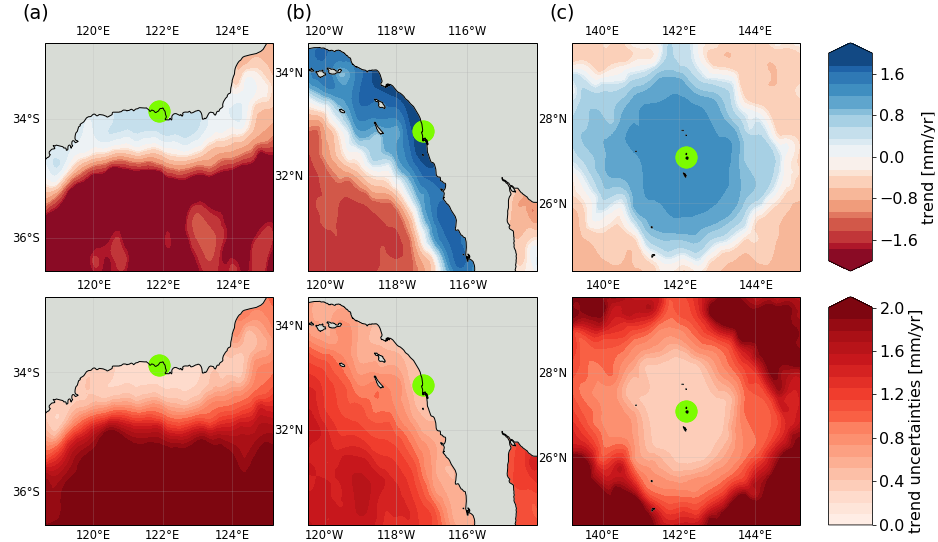
Figure 6. VLM SAT-TG trends (first row) and uncertainties (second row) mapped onto relative correlation levels. The mapping and interpola- tion method is further elucidated in Appendix A. We show the same stations (a–c) as in Fig.